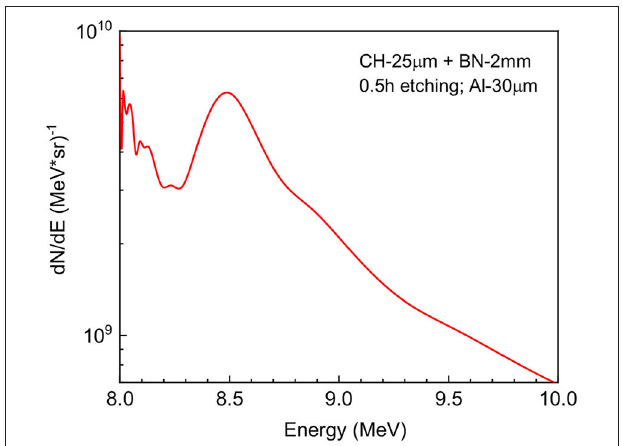
FIGURE 5 | α -particle energy spectrum corresponding to Figure 3 converted from the flux measured in the CR39 facing the target rear side, averaging over 10 different areas of the same detector. Based on ion track counting technique, the total number of α -particles is 5 × 10 9 /sr ± 20%.